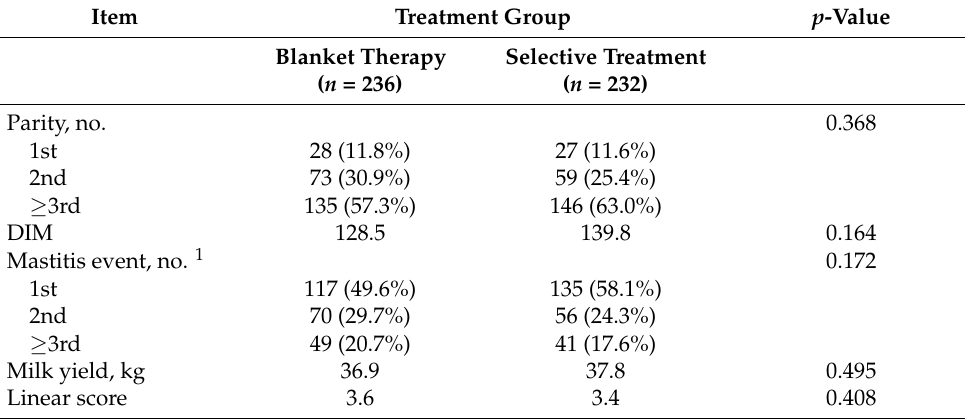
Table 1. Cow level descriptors for each treatment group.